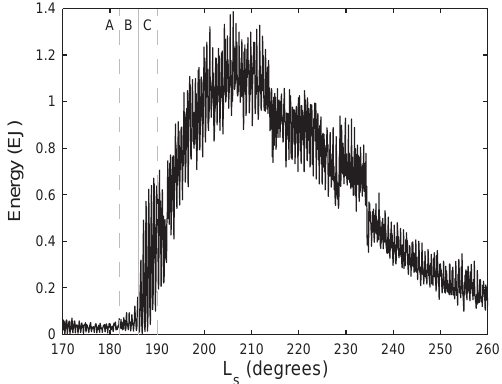
Fig. 4. Energy evolution in the pair EOF6–7 which primarily rep- resents the semidiurnal tide. Line B represents the time of the dust outburst over Hesperia Planum and Tyrrhena Terra. Lines A and C represent the limits of the interval analysed in the present study.